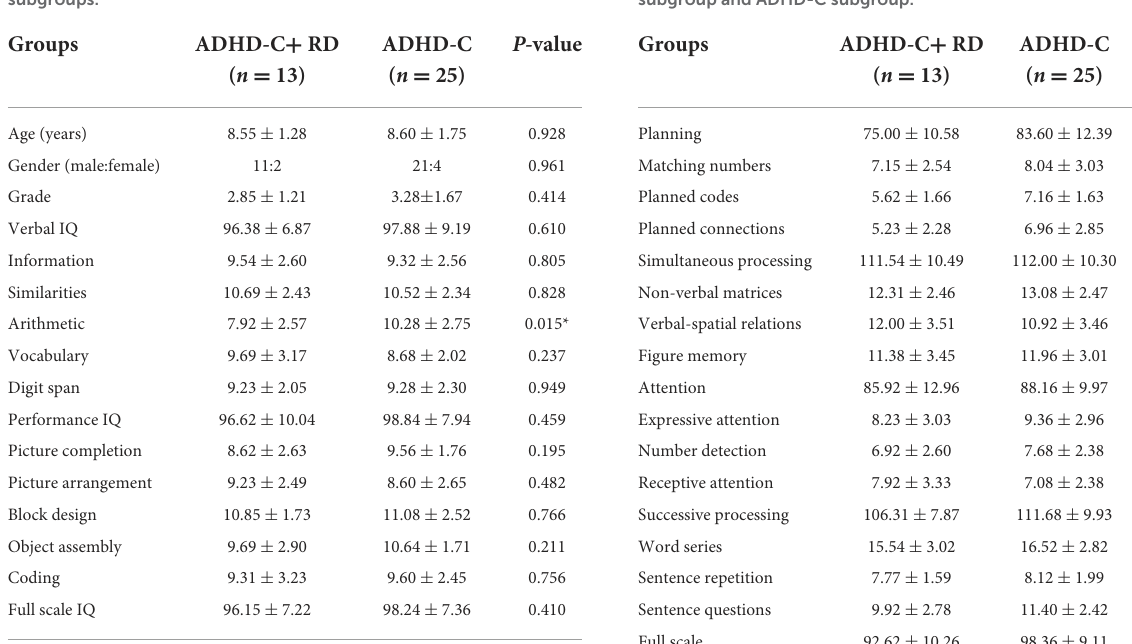
ComparisonofDN:CASfullscaleandsubscalescoresbetweenADHD-C + RDsubgroup and ADHD-C subgroup were done by student’s t- test, * means P < 0.05, ** means P < 0.01.Thedataareshownasmean ±